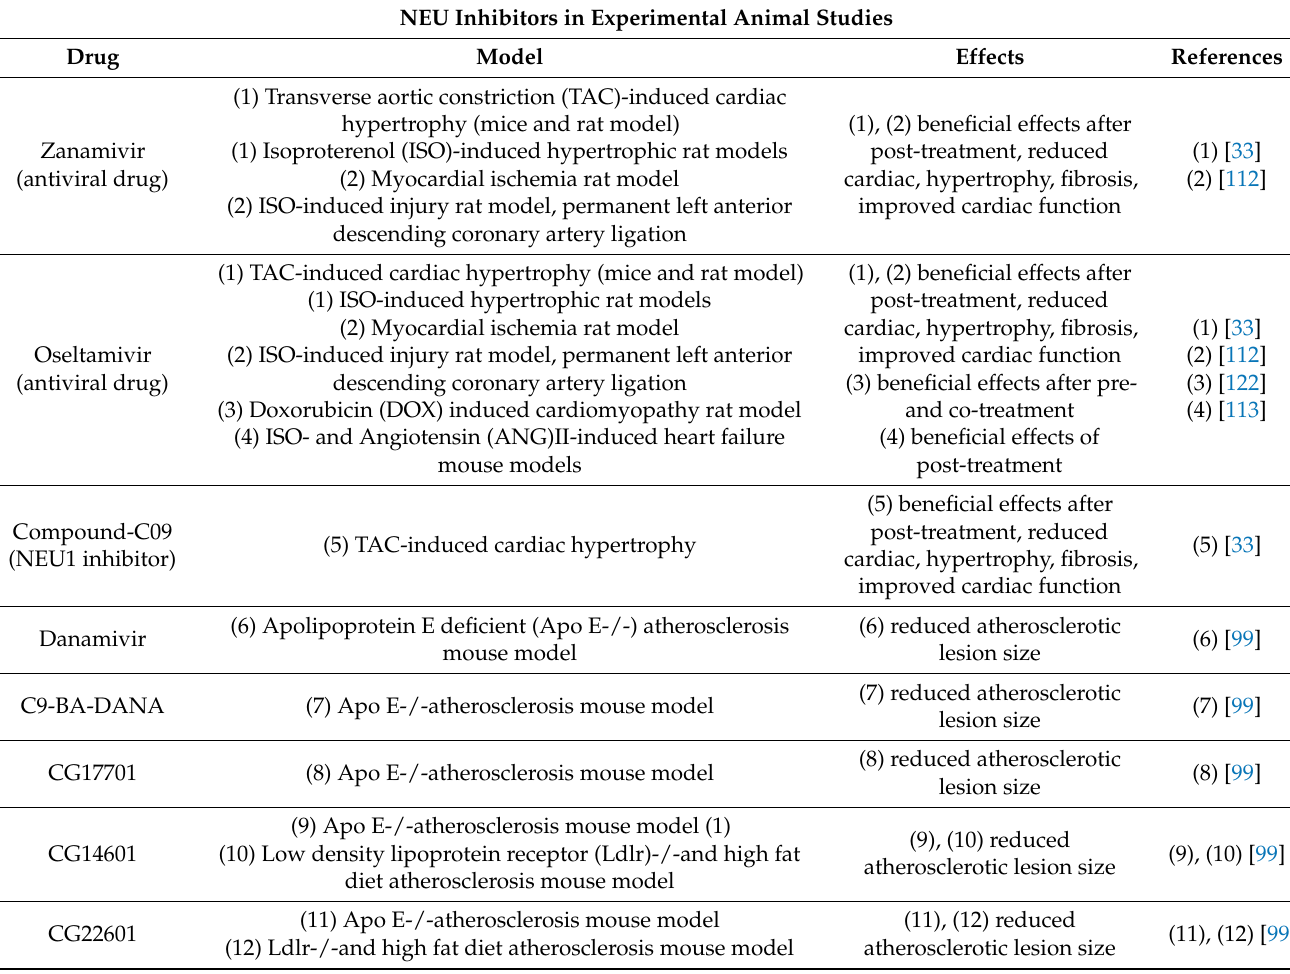
Table 2. Overview of experimental studies targeting NEUs in cardiovascular diseases.